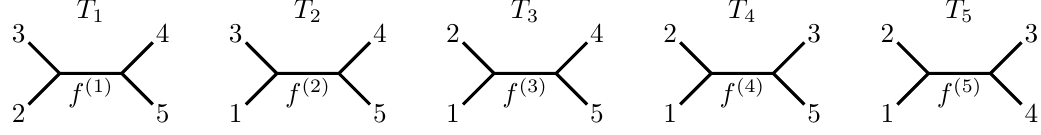
Figure 2 . Abstract tree arrangement { T 1 , T 2 , T 3 , T 4 , T 5 } obtained from the tree in figure 1 by pruning one leaf at the time. It is also a metric tree